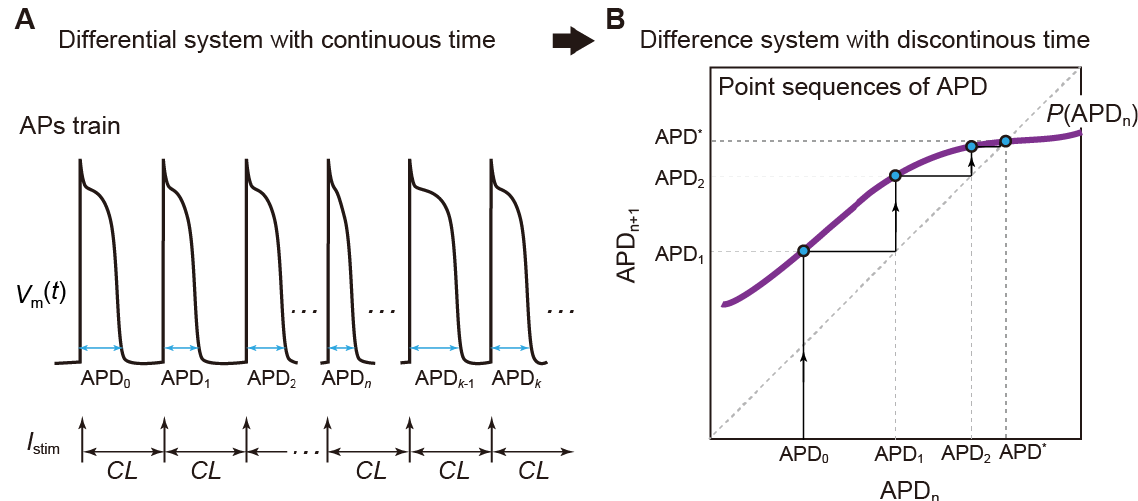
Figure 5. Examples of a dynamical system with continuous time and with discrete time. ( A ): An action potential (AP) train evoked in a cardiomyocyte with stimuli ( I stim ) applied at a cycle length of CL , which is a typical example of the response of a dynamical system with continuous time. AP duration of the AP evoked by the i th stimulus is denoted as APD i for i = 0, 1, 2, …, n , … , k − 1, k , …. ( B ): A point sequence consisting of APD values determined for the AP train and plotted on the (APD n , APD n +1 )-plane. If a mapping P (Poincaré map) is obtained to represent the relationship be- tween a point (APD n ) and the next point (APD n +1 ), i.e., the dynamics of the point sequence, then the differential system with continuous time is transformed into a difference system with discrete time.